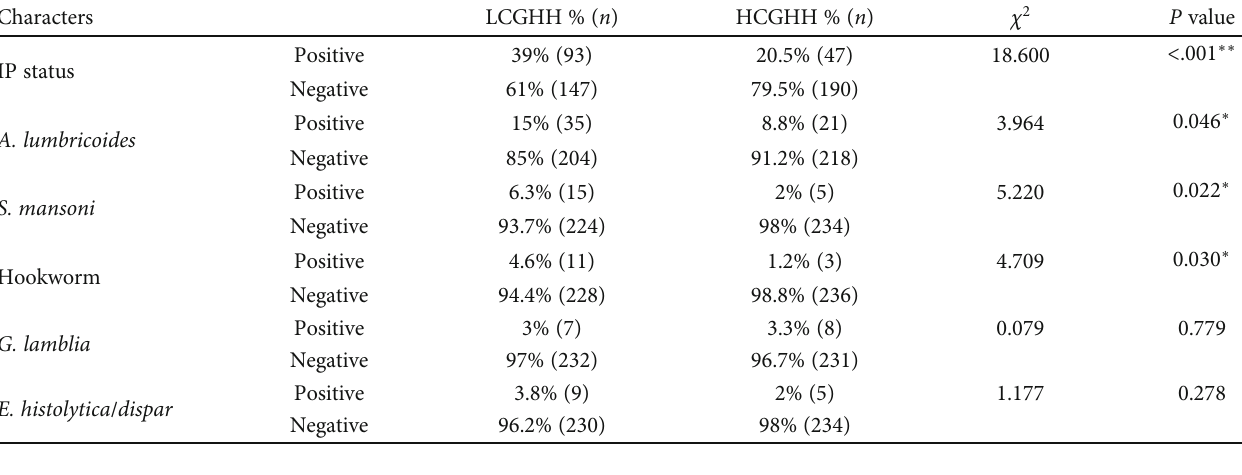
Table 2: Prevalence of intestinal parasite infections in low and high coverage of graduated households ’ districts, Northwest Ethiopia